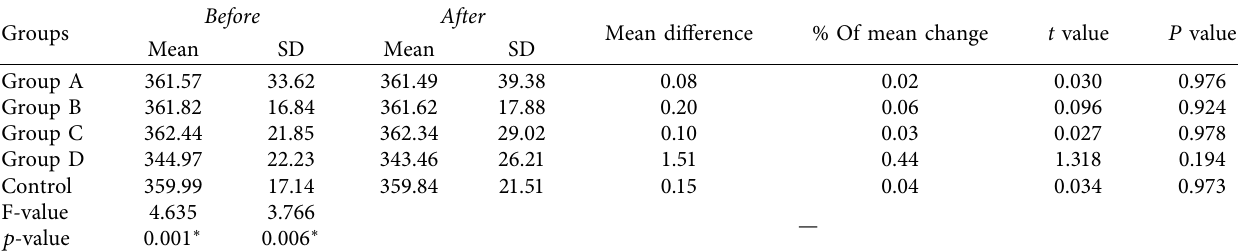
Table 7: Left side masseter muscle amplitude before and after treatment.